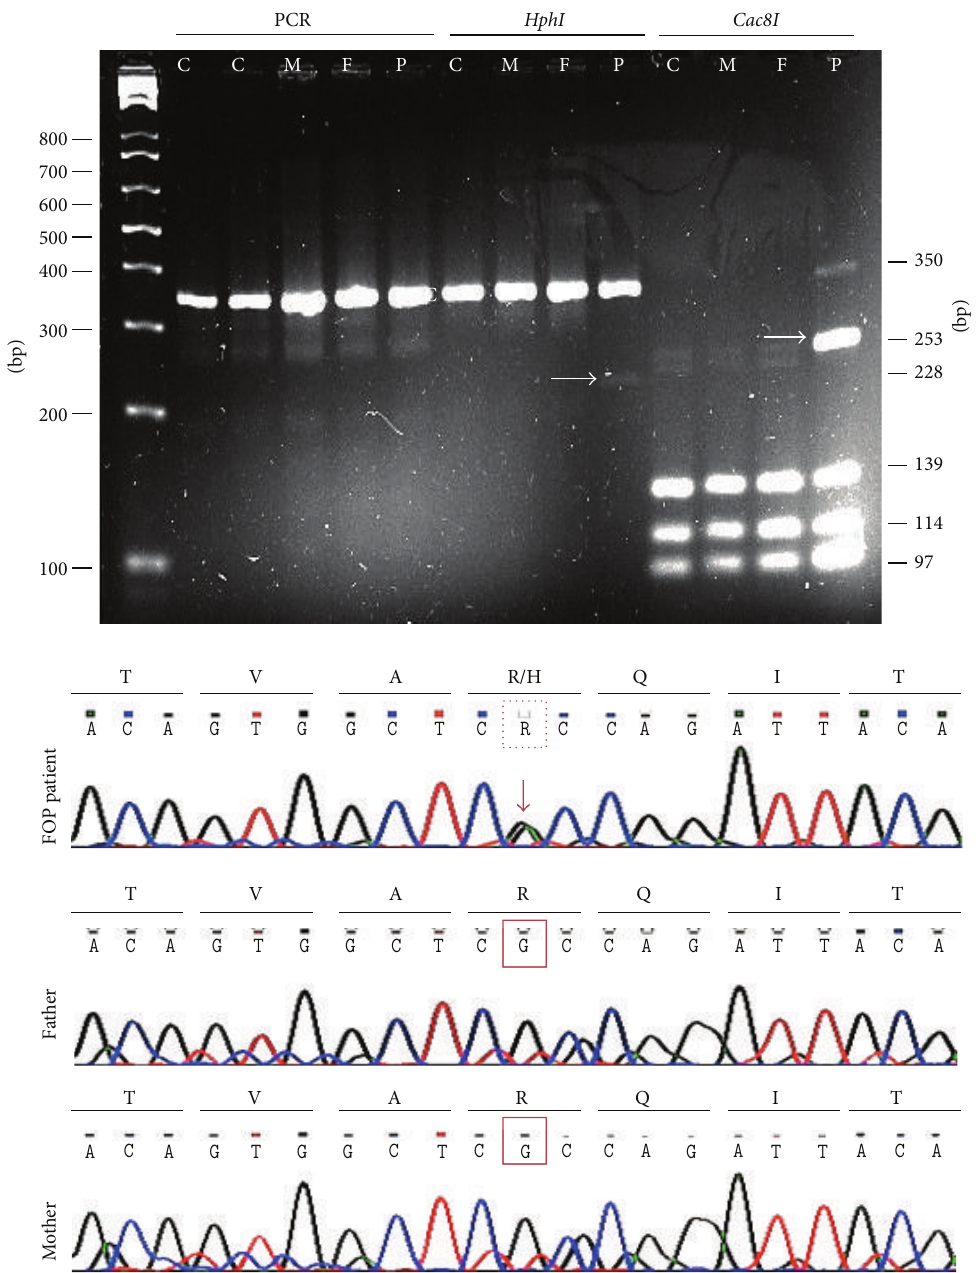
Figure 2: Genotyping in top panel: PCR amplification products were resolved by 3% agarose gel electrophoresis (C: control, M: mother, F: father, and P: FOP patient). As shown on the left, similar 350 bp products were amplified in controls, relatives, and the FOP case; however, after Cac8I digestion, a 253 bp fragment was observed exclusively in the FOP patient (marked with arrow). Bottom panel: a chromatogram showing the typical mutation at position 617, which causes an amino acid substitution of histidine for arginine at position 206 in the GS domain of